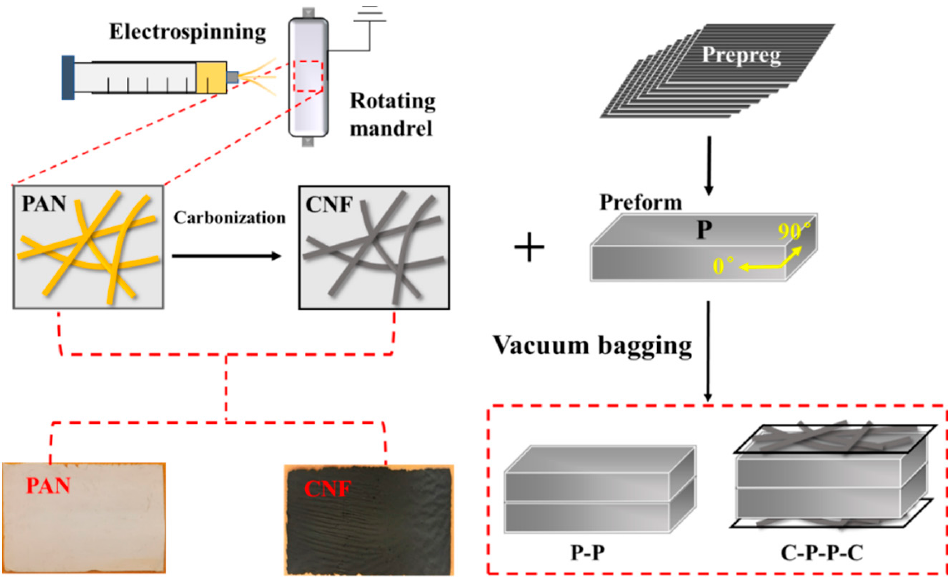
Figure 1. Schematic illustration of the preparation process of composites.